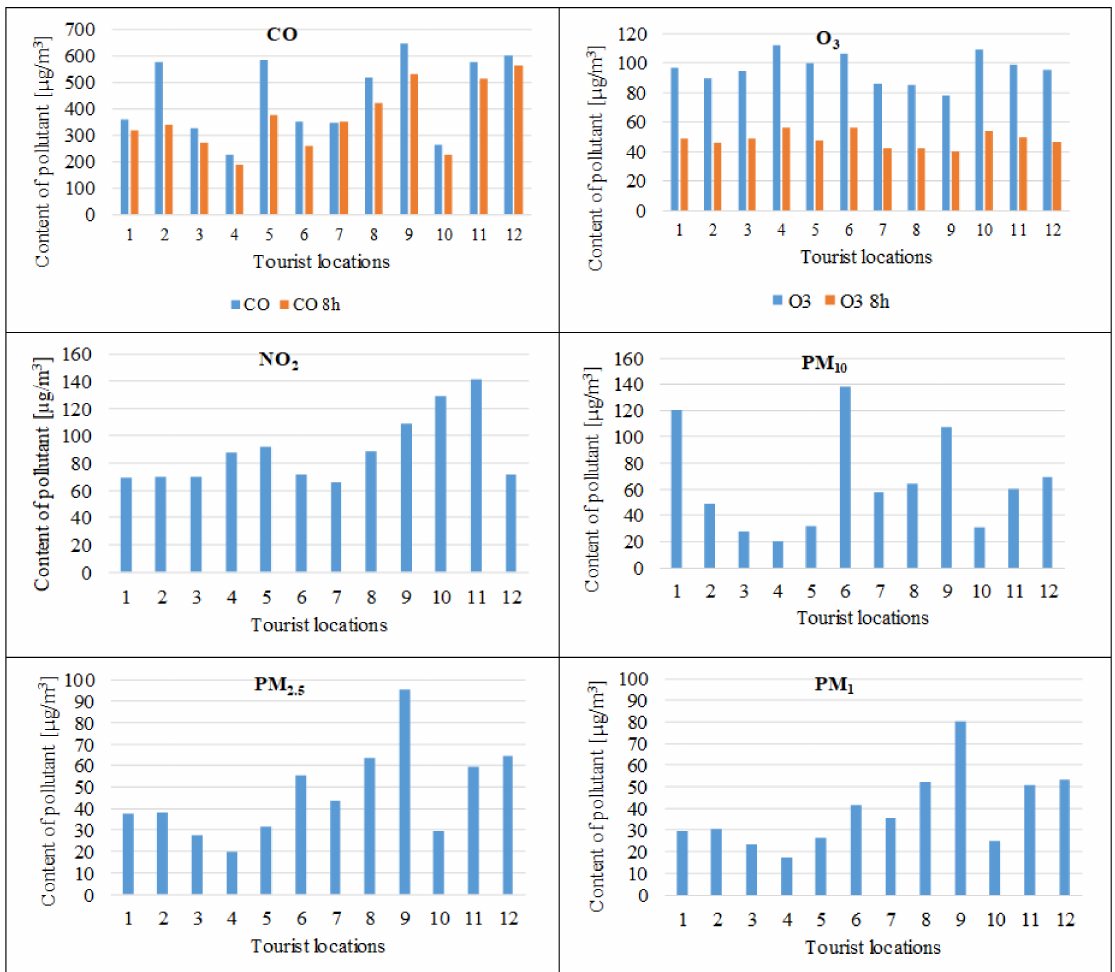
Figure 3. Mean pollutant contents measured in outdoor air on the research area during the measurement period in the winter season of 2017/2018 (for location numbers see Figure 2; modified after